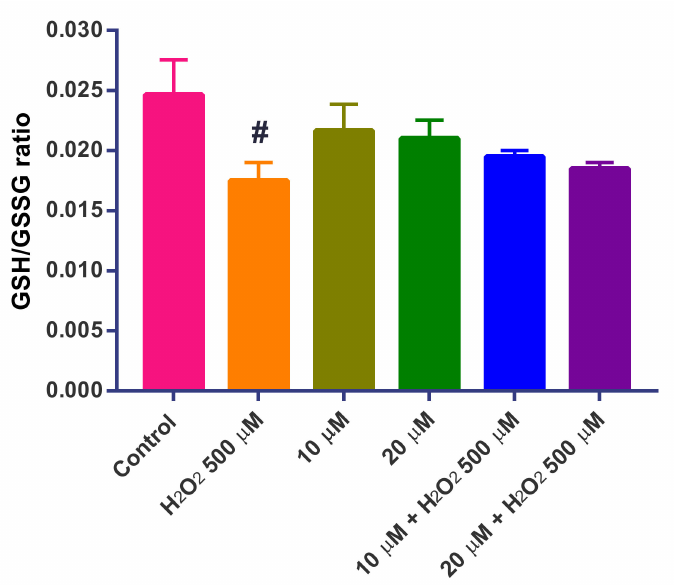
Figure 23. GSH/GSSG ratios determined for compound 18 at 10 and 20 µ M in SH-SY5Y cells under H 2 O 2 500 µ M oxidative stress. Data are presented as the Mean ± SD of four independent experiments carried out in triplicate. # p < 0.001 vs. vehicle-treated control.